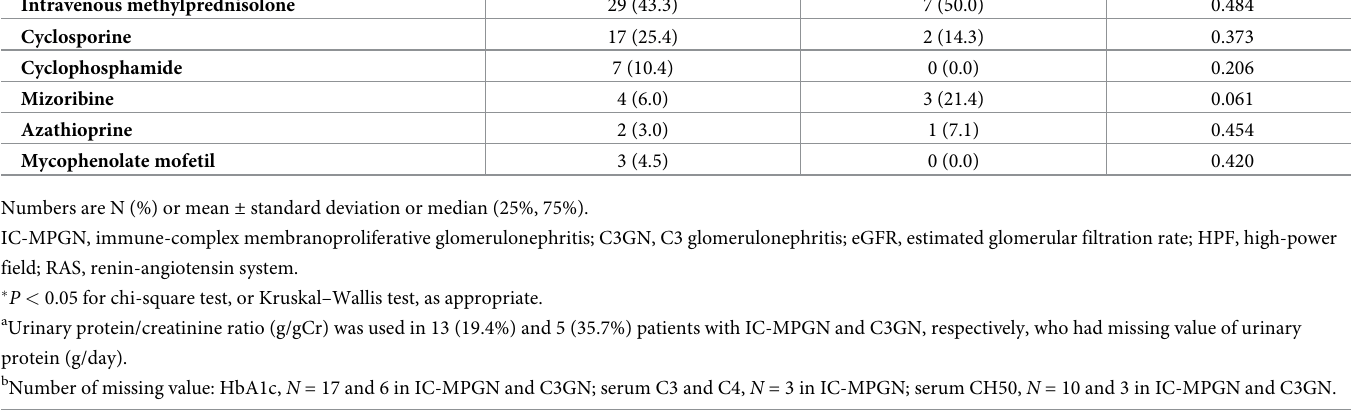
24.0 mg/dL), and CH50 (31.7 vs. 43.5 U/mL) at the time of diagnosis. The two patient